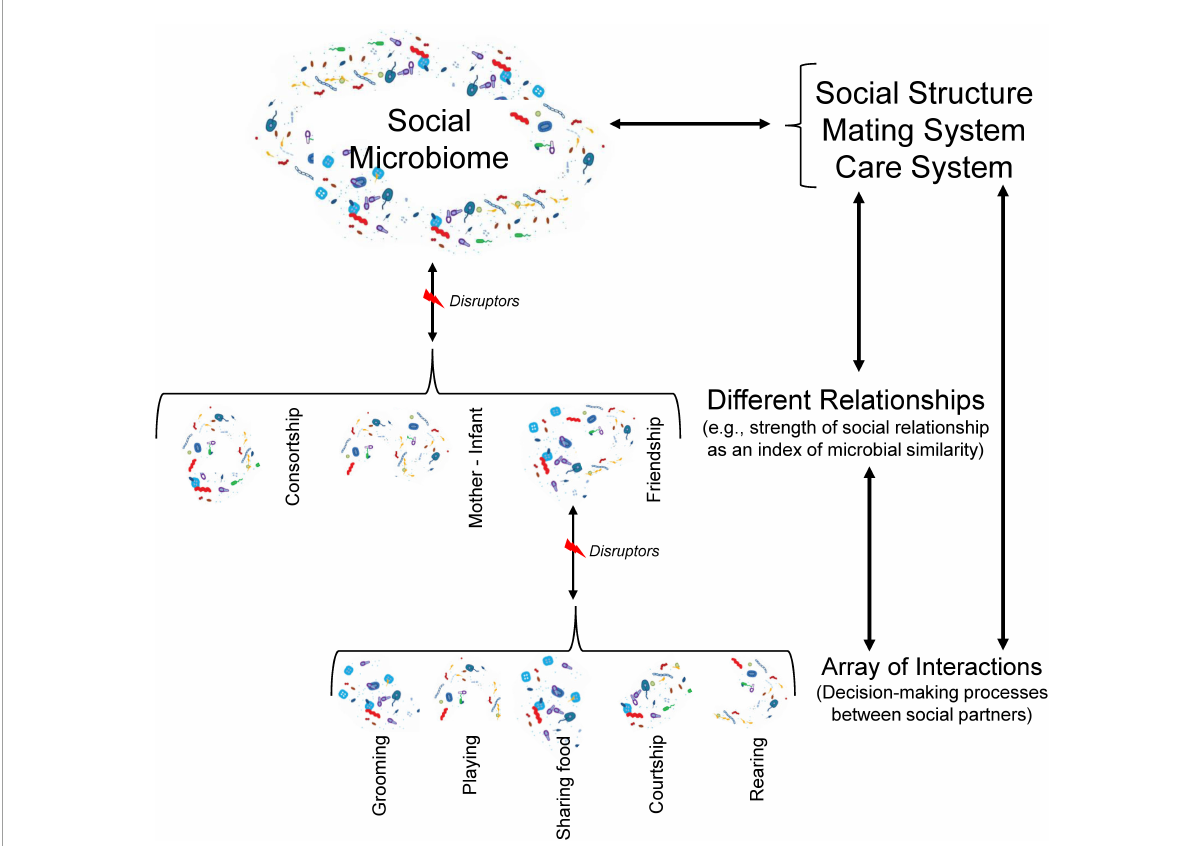
FIGURE2 Individuals as microbial patches are connected by interactions, which result from a decision-making process (e.g., to whom care, with whom play or share food). Different microbes (in terms of quality and quantity) may be transmitted between partners in each kind of interaction. It is likely that many gut microbes could be exchanged during interactions involving mouth-anogenital contact. The nature (social, mating, and rearing contexts) and patterning (frequency and duration) of interactions determine the kind and strength of a relationship between two individuals (e.g., friendship, consort, etc.), which has been associated with microbial similarity (Montiel-Castro et al., 2013). This microbial exchange across distinct levels (interactions, relationships, and social components), however, may be disrupted by removal and/or social integration of individuals (such as juveniles or immigrants) into the social network, hosts’ properties (such as age, sex, health condition), environmental conditions (like humidity, temperature), and survival and colonization strategies of gut microbes. Patterns of different relationships define the social structure and mating and care systems, which influence the social microbiome. As microbiota-gut-brain axis suggests a bidirectional communication between enteric and nervous system (Hyland and Cryan, 2016), we will expect the social microbiome, in turn, influences different levels of social complexity of primate groups. In this figure, we also highlight the reciprocal influence among the three levels of social